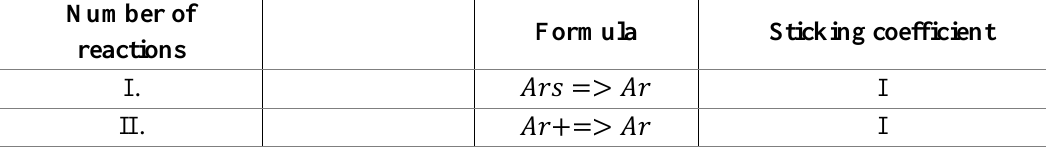
Table 2: 𝑨𝒓 gas reaction and collisions [17].